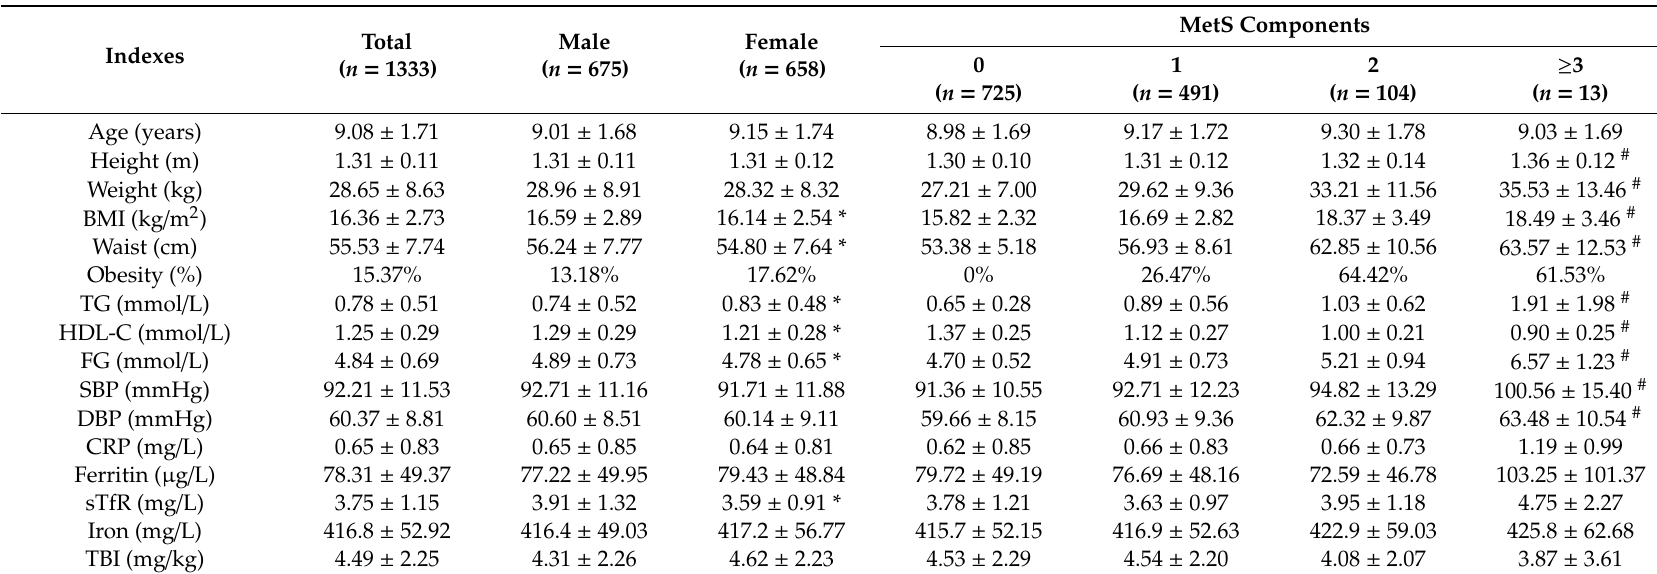
Table 1. Basic characteristics according to gender and the number of metabolic syndrome (MetS)